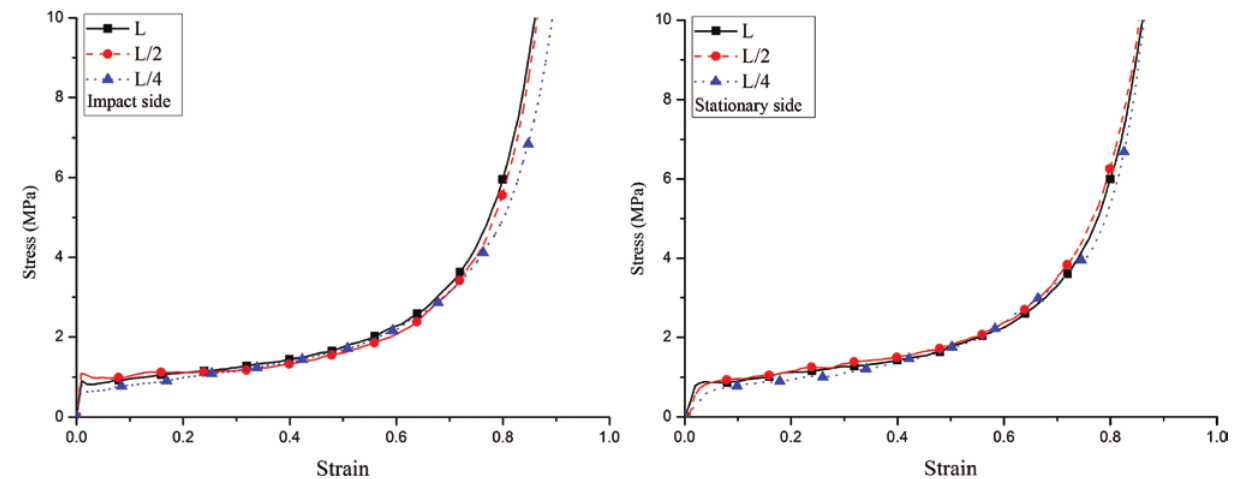
Figure 2: Nominal stress-strain curves at both sides with V = 10